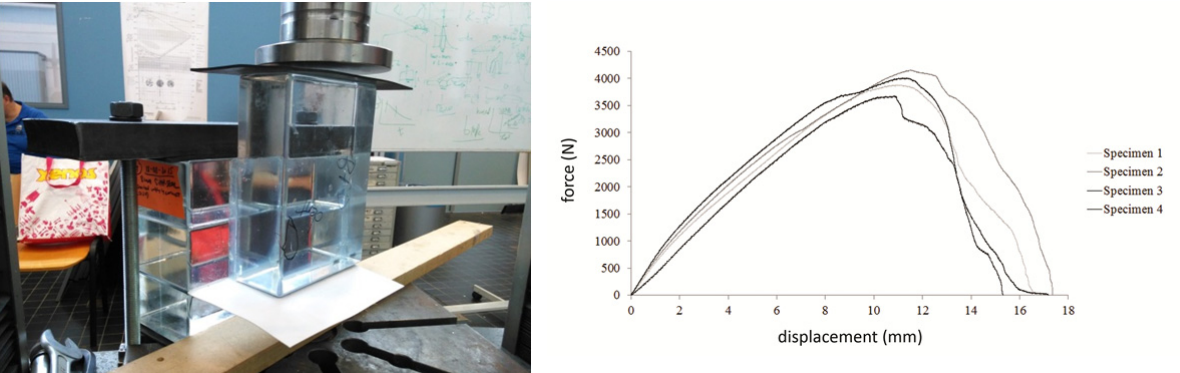
Fig. 12 Experimental set-up of the shear test Fig. 13 Force to deformation graphs of the specimens tested in